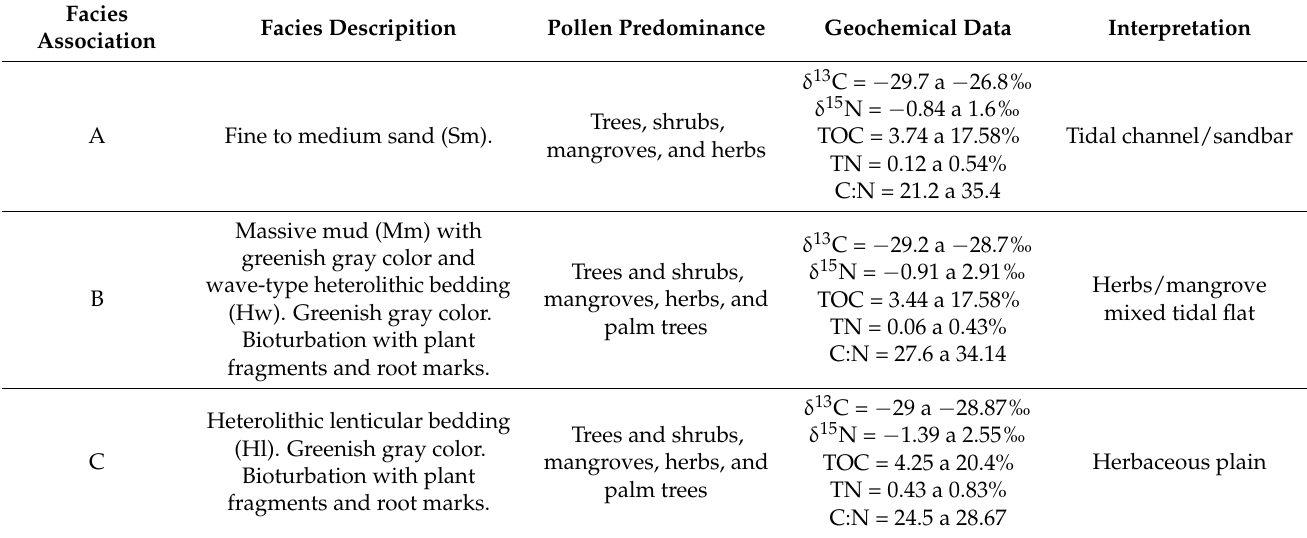
Table 2. Summary of the facies association with sedimentary characteristics, predominance of pollen groups, and geochemical